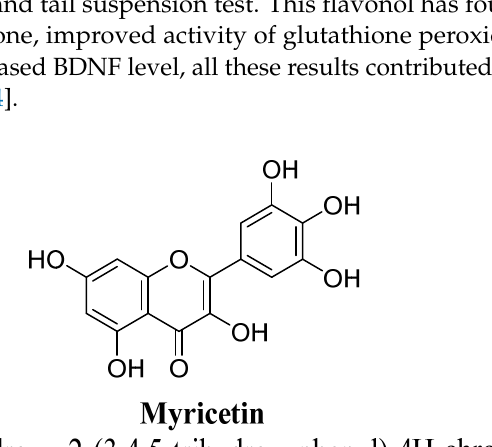
Figure 25. Myricetin. Myricitrin (glycosyloxyflavone or pentahydroxyflavone) is a 3-O- α -L-rhamnopyranoside of myricetin in which myricetin is attached to α -L-rhamnopyranosyl residue at position C3 via glycosidic linkage (Figure 26) [105]. In literature, it has been found to possess antioxidant, anti-fibrotic and anti-inflammatory activities [105]. Pre-clinically, it has shown potent anti-depressant potential in tail suspension test using mice. This effect was proposed to be mediated through inhibition of nitric oxide and hippocampal neurogenesis [106]. In addition, myricetin increases neuronal proliferation, growth and their survival, especially in the subventricular zone and the subgranular zone [106].